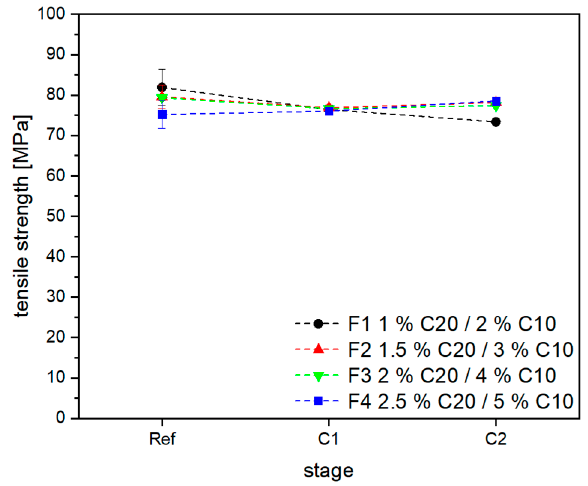
Figure 17. Tensile strength of the four formulations F1–F4.